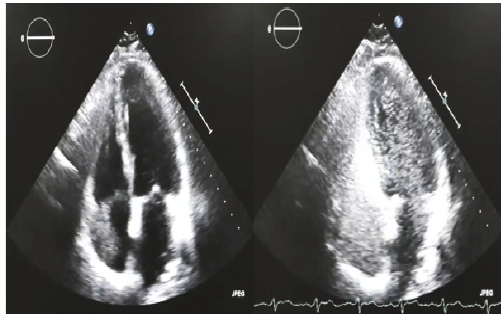
Figure 4: Contrast-enhanced transthoracic echocardiography showing contrasts’ microbubbles in the left side of the